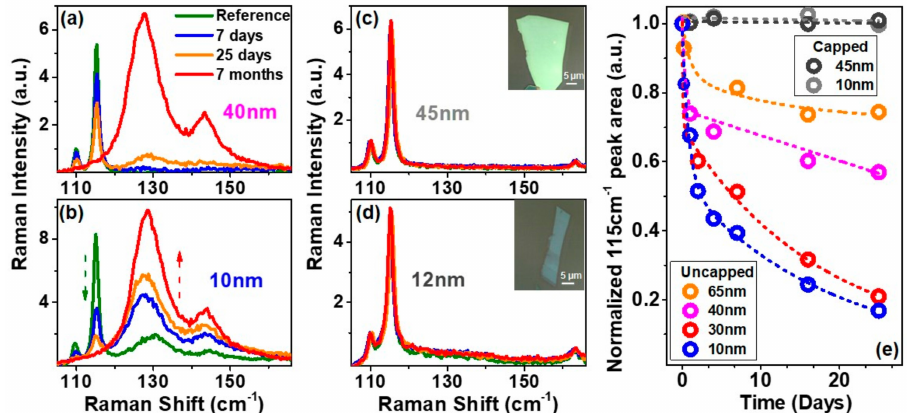
Figure 2. Room temperature Raman spectra of mechanically exfoliated GaTe flakes with a thickness of ( a ) 40 nm and ( b ) 10 nm at the reference point for uncapped flakes and after exposure to ambient air for 7 days, 25 days, and 7 months; Raman spectra of HSQ-capped flakes with thickness ( c ) 45 nm (optical image shown in inset) and ( d ) 12 nm (optical image shown in inset) at the reference point for HSQ-capped flakes and after exposure to ambient air for 7 days, 25 days, and 7 months; ( e ) The normalized 115 cm − 1 Raman peak area for uncapped flakes of thicknesses 65 nm, 40 nm, 30 nm, 10 nm, and HSQ-capped flakes representative of the thin (8 nm–15 nm) and thick (30 nm–60 nm) regimes are shown in light grey and dark grey dotted lines,